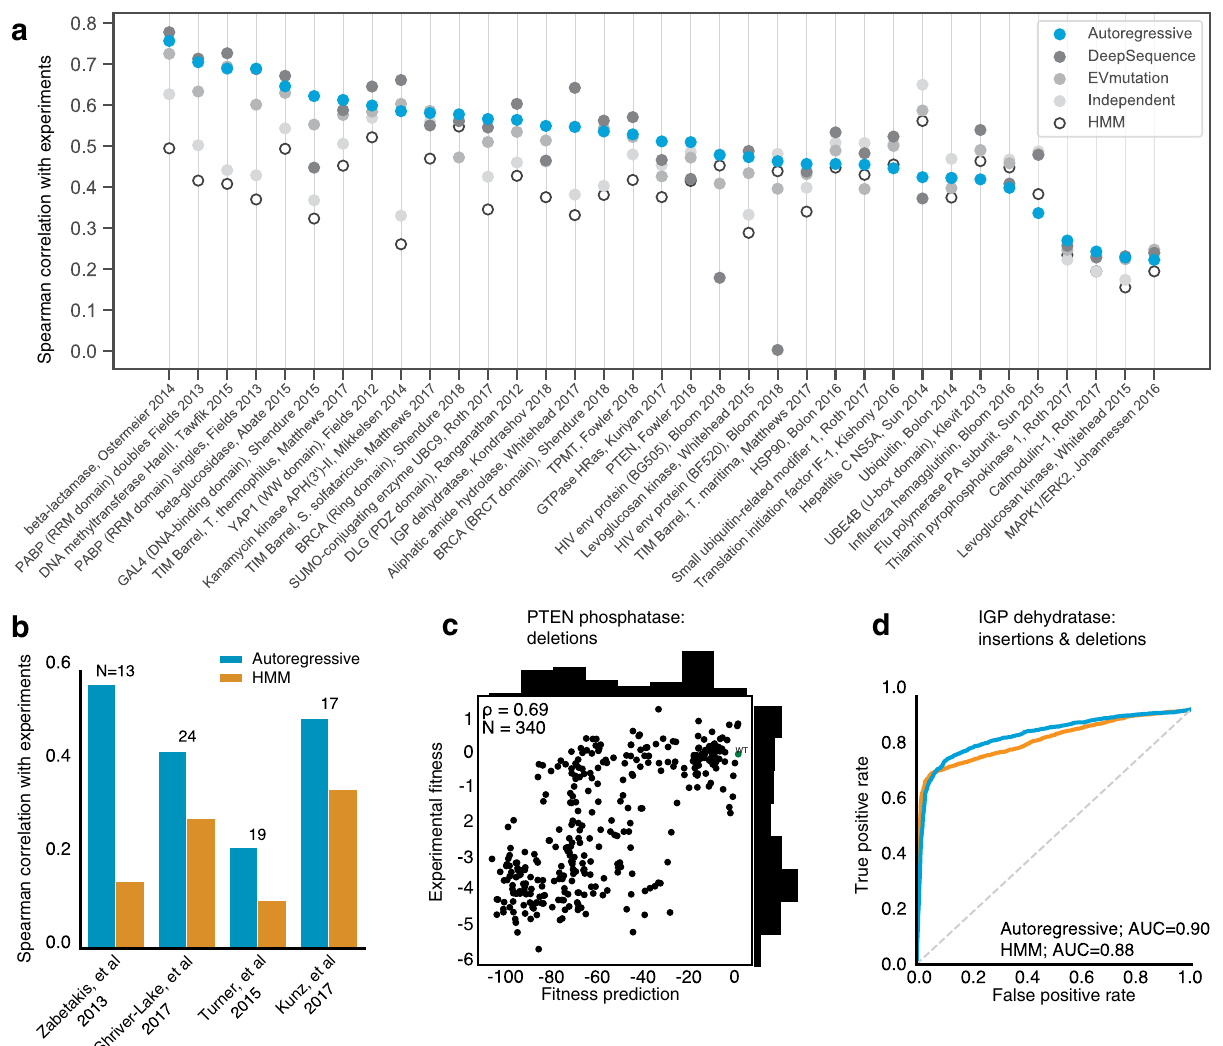
Fig. 2 Validation of the autoregressive model in learning the genotype to phenotype map. a Even without using alignments, the autoregressive model (blue) can competitively match mutation effect prediction accuracies of state-of-art alignment-dependent models, such as conservation (light gray), evolutionary couplings (gray), and DeepSequence (dark gray) 30 . In addition, the mutation effect prediction accuracies improve upon hidden Markov model 74 (HMM, white) accuracies. Without using alignments, the autoregressive model matches alignment-dependent state-of-art missense mutation effect prediction (DeepSequence) for 40 different deep mutational scan experiments. Three datasets show signi fi cant improvement with the autoregressive model: HIV env (BF520), HIV env (BG505), and Gal4 DNA-binding domain. b The autoregressive model (blue) can learn from natural sequence repertoires of llama nanobodies to predict the thermostability of llama nanobody sequences with variation in the framework and complementarity determining regions with greater accuracy than HMMs (orange). The number of llama nanobody sequences from each study is shown above each pair of bars. c Fitness predictions for single deletions in PTEN phosphatase compared with measured experimental fi tness is accurate, with a Spearman correlation of 0.69. d Accurate prediction of binary fi tness for IGP dehydratase with a range of insertions, deletions, and missense mutations of the autoregressive model (blue), higher than HMM